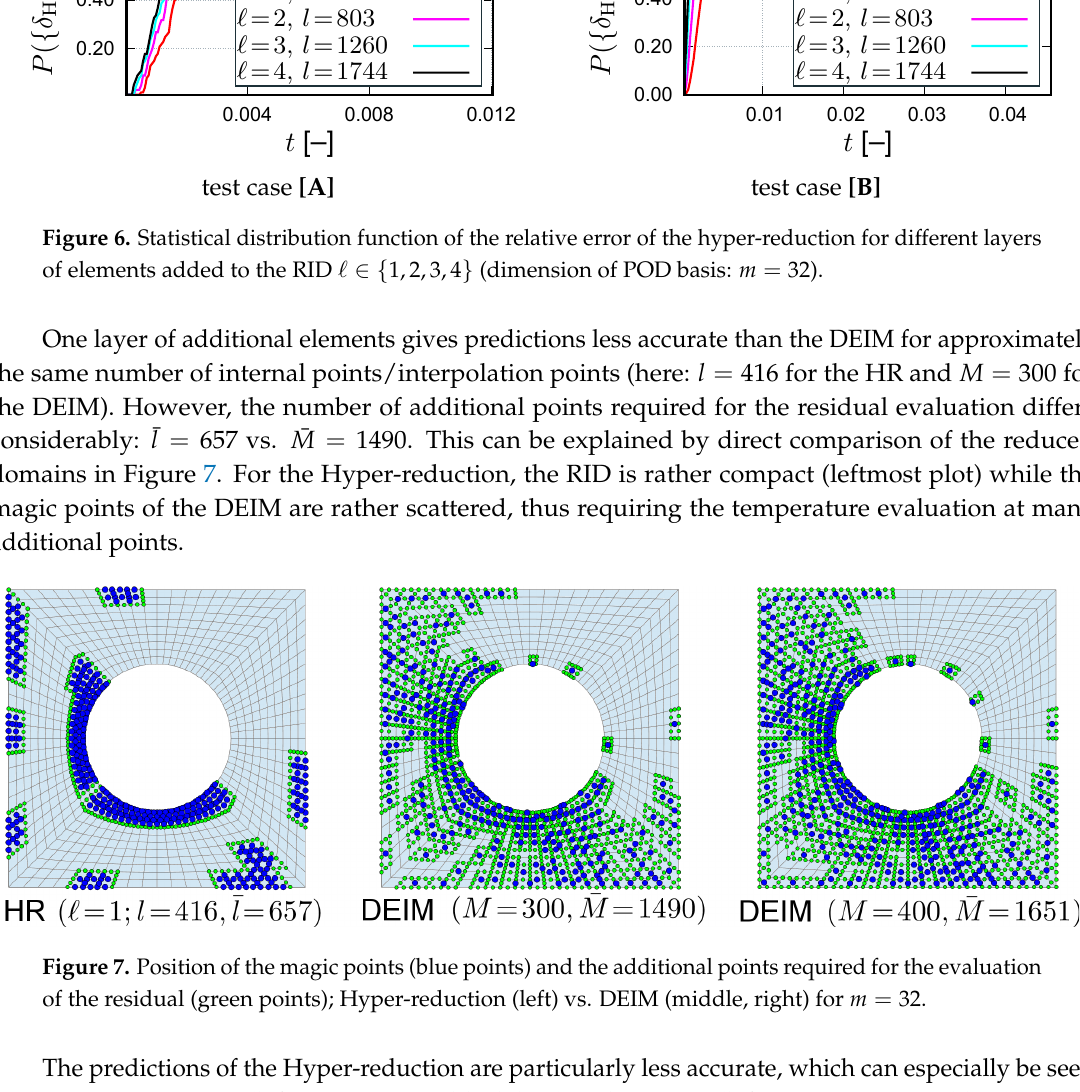
1,2,3,4 (dimension of POD basis: m = 32). ∈ { }